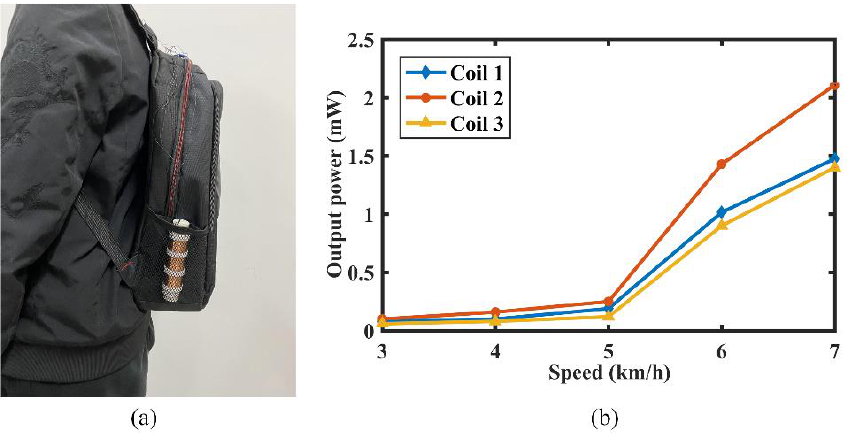
Figure 16. ( a ) Picture of the MCEEH put in a backpack vertically; ( b ) the output power of MCEEH at different speeds.